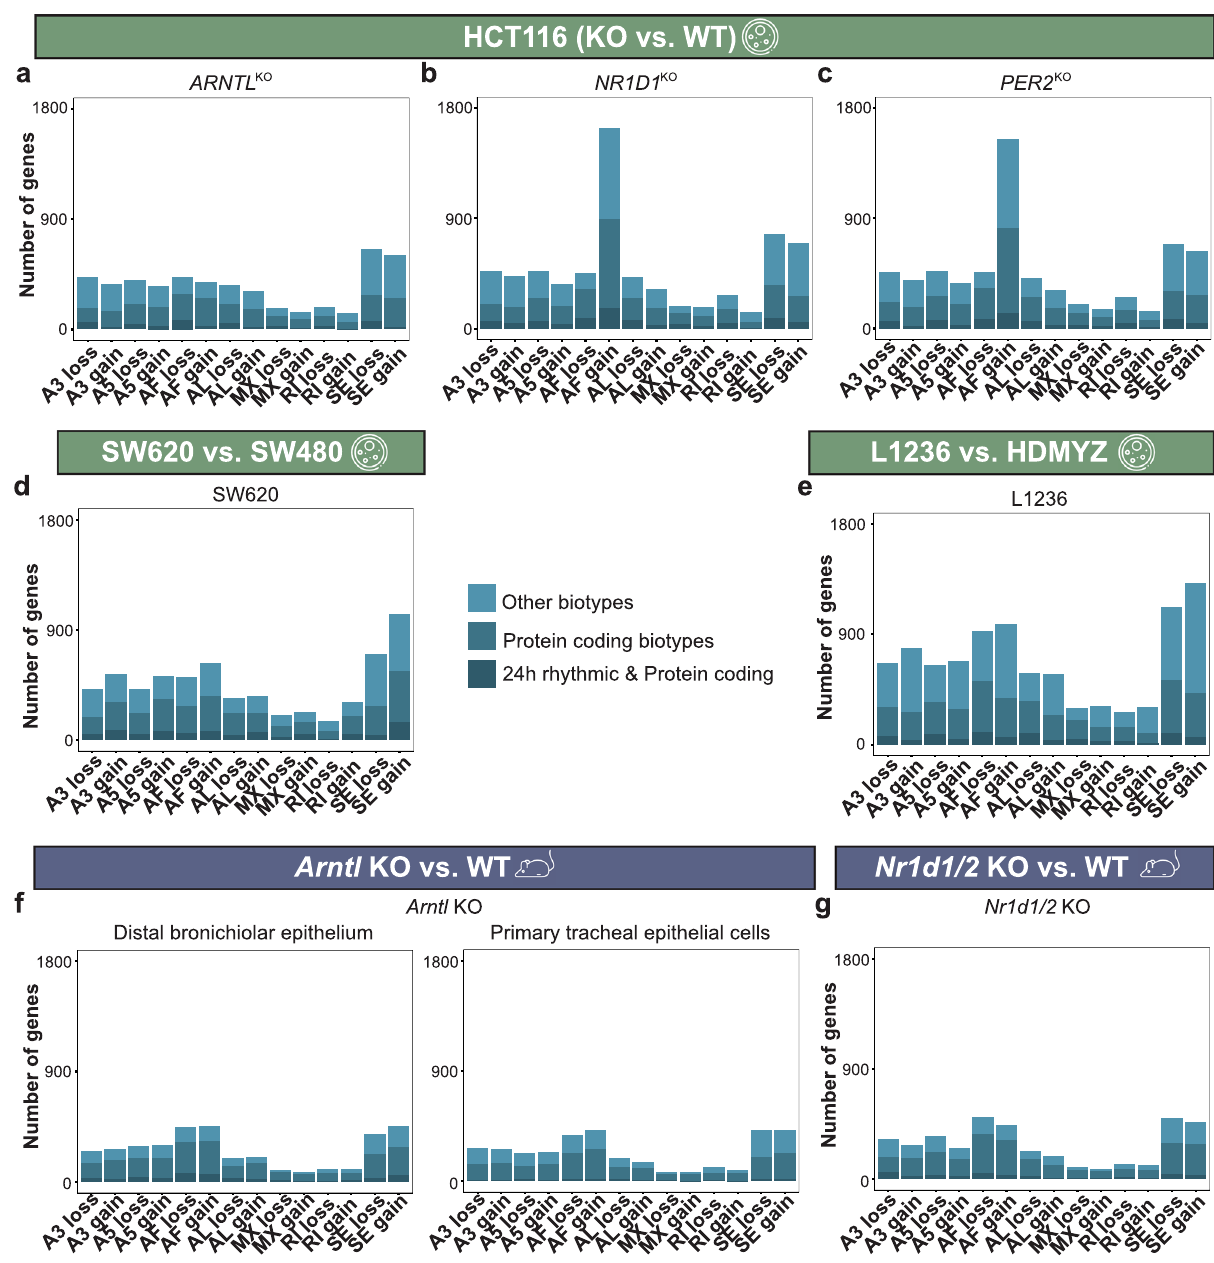
and HCT116_ PER2 KO vs. HCT116_WT cells, ( d ) in the SW620 vs. SW480 cells, ( e ) in the L1236 vs. HDMYZ cells, ( f ) in Arntl KO from distal bronchiolar epithelium (left) and from primary tracheal epithelial cells (right) vs. their WT, and ( g ) in Nr1d1/2 KO vs. WT. In each barplot,